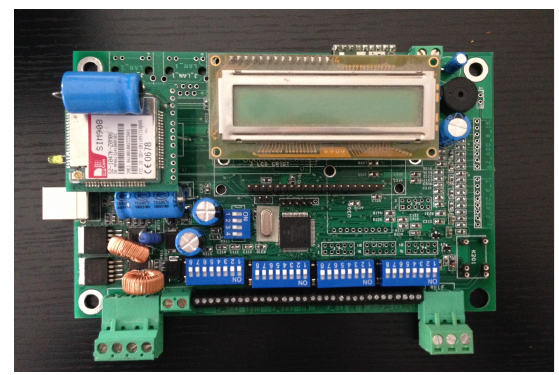
Figure 2. Used prototyping